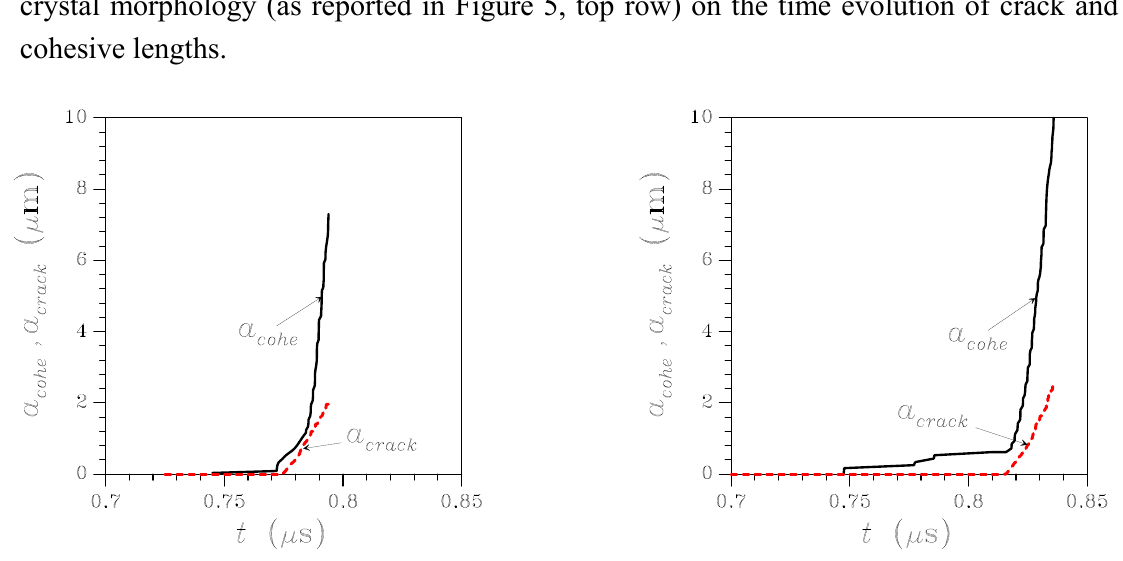
Figure 6. Micro-structure A, perfect GB case ( GPa): effect